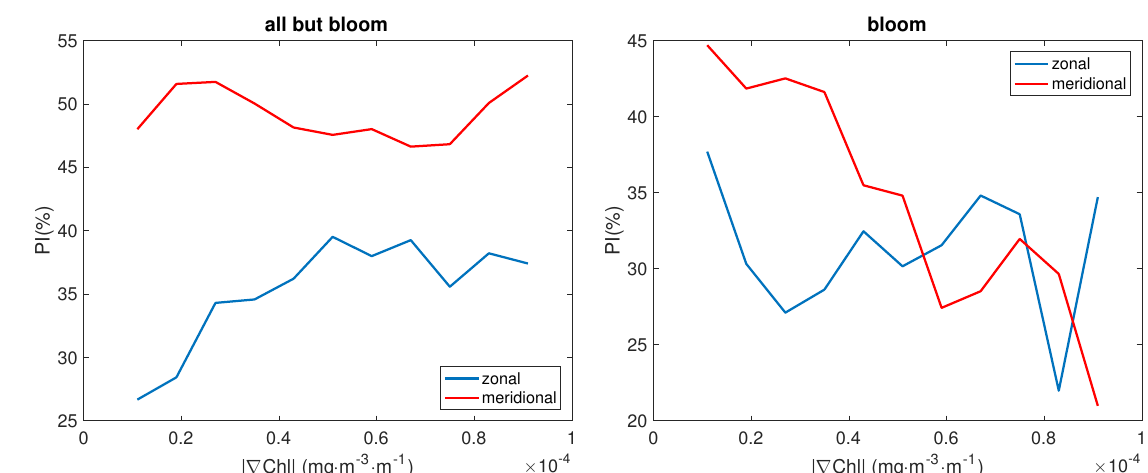
Figure 8. ( Left ) improvement of the zonal (blue) and meridional (red) optimal currents with respect to the Synthetic Altimeter estimates (January to Mid-February and Mid-March to December 2017). ( Right ) same as left, in the period mid-February to mid-March